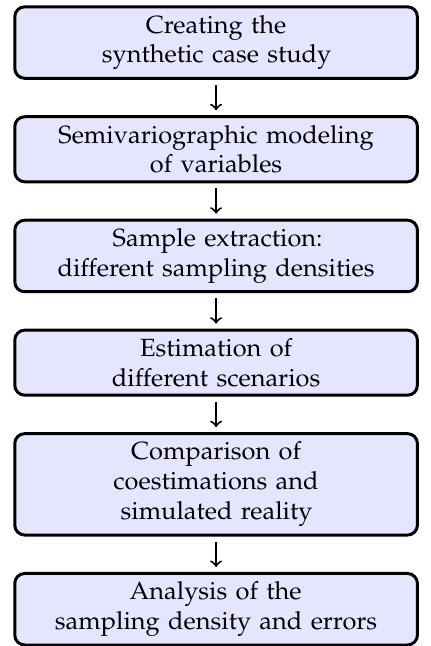
Figure 1. Sequence of the main stages of the